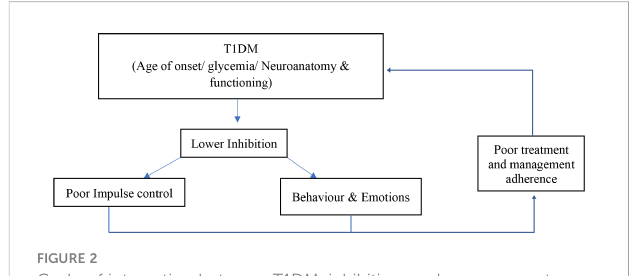
FIGURE 2 Cycle of interaction between T1DM, inhibition, and